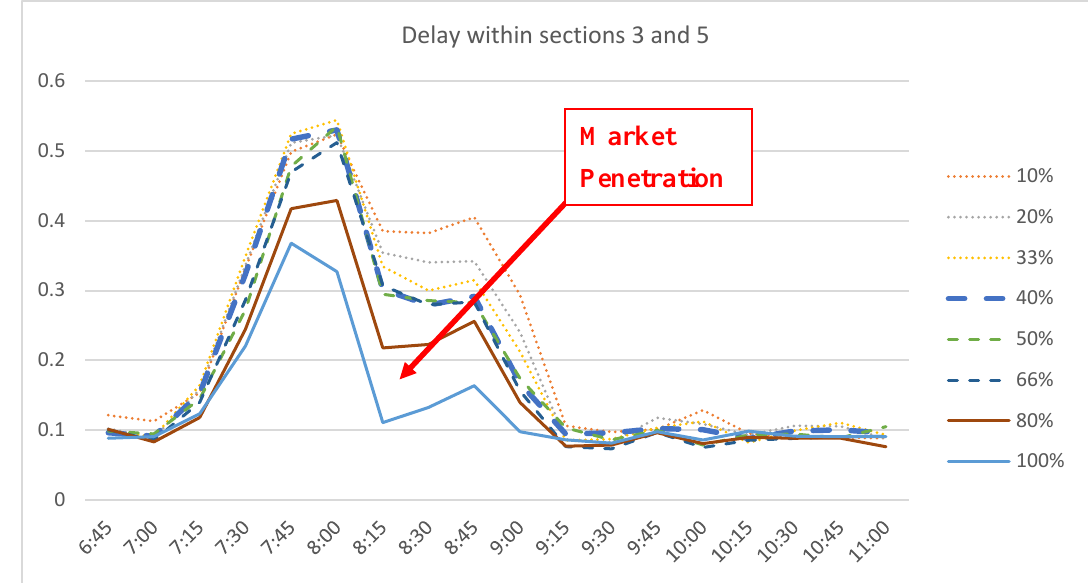
Figure 12. Percentage of delay — comparison between desired speed and actual speed .